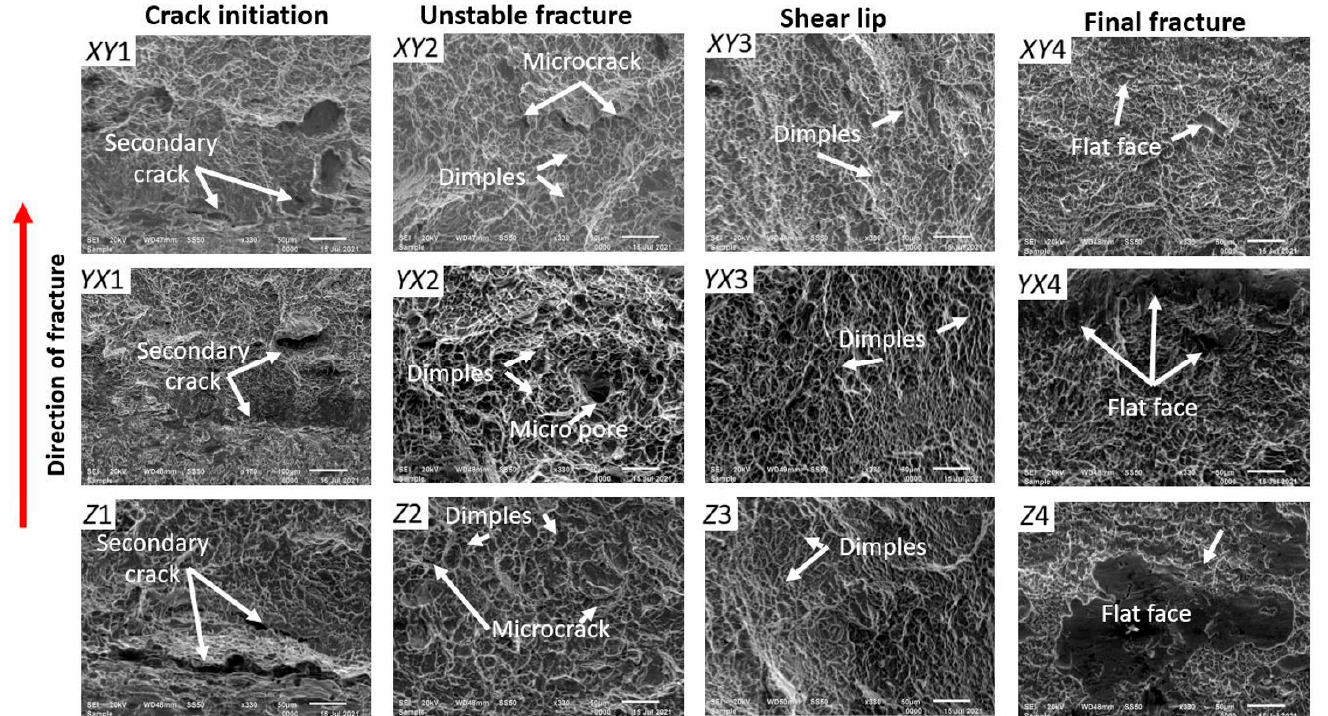
Figure 7. Fracture surfaces of the various regions of fracture for the Charpy impact toughness specimens built with different orientations ( XY , YX , and Z ).